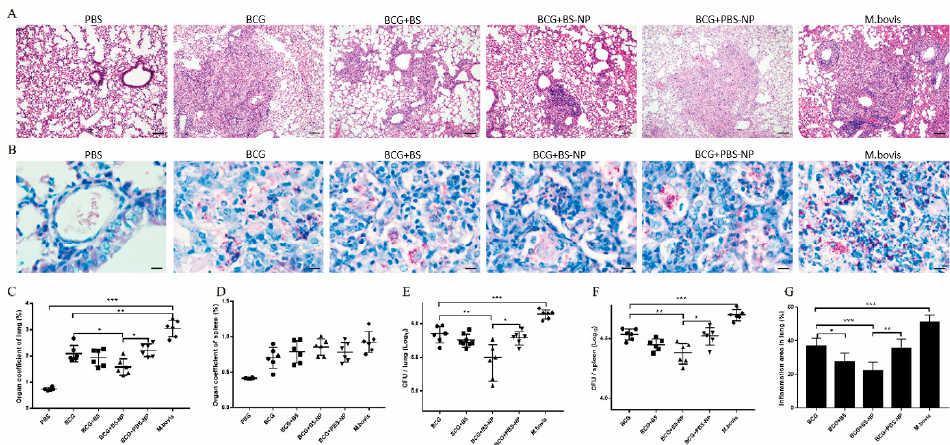
Figure 6. B5-NPs reduce pathological damage of lung. ( A , B ) Histopathological evaluation of lung tissues was performed with hematoxylin and eosin (H&E) staining ( A ) and acid-fast staining ( B ) four weeks after challenge with M. bovis strain. The top panel ( A ) shows images at × 100 magnification (scale bars, 100 µ m); the bottom panel ( B ) shows images at × 1000 magnification (scale bars, 10 µ m). ( C – F ) The organ coe ffi cient of lung ( C ) and spleen ( D ), the number of viable bacteria in the lungs ( E ) and spleen ( F ) were determined 4 weeks after challenge with M. bovis strain. ( G ) Percentage of lung area involved in inflammation lesions relative to total lung area used for morphometric analysis. Data shown are representative of six mice per group. Data collected are expressed as the mean ± SD. (* p < 0.05; ** p < 0.01; *** p <